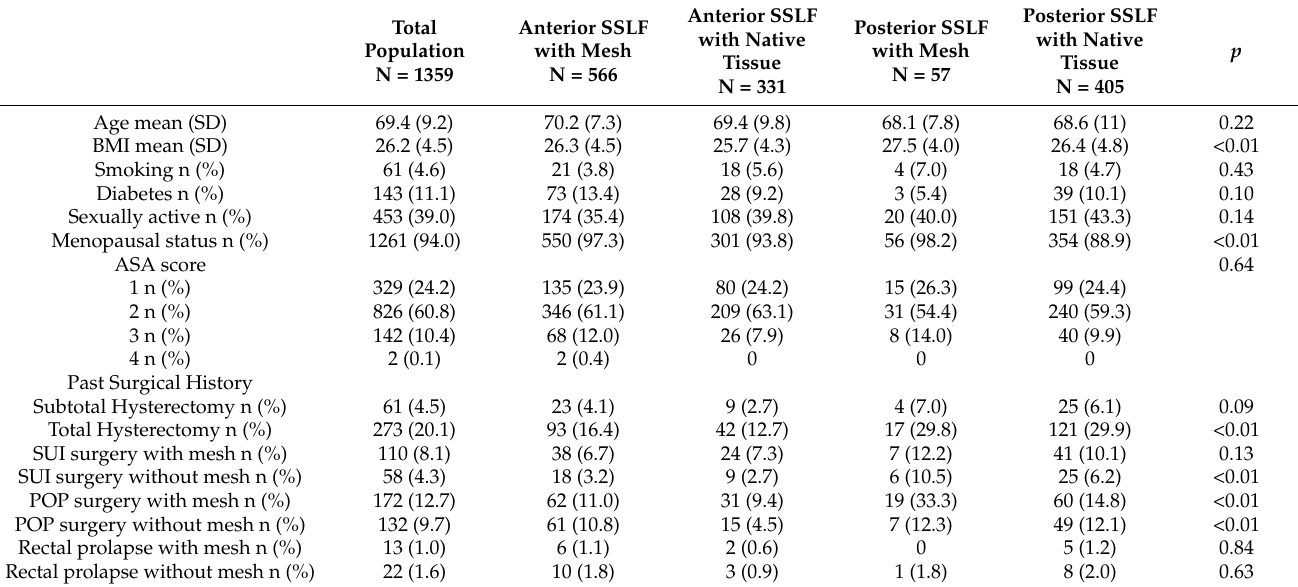
Table 1. Baseline characteristics for the total population and between the four surgical groups.